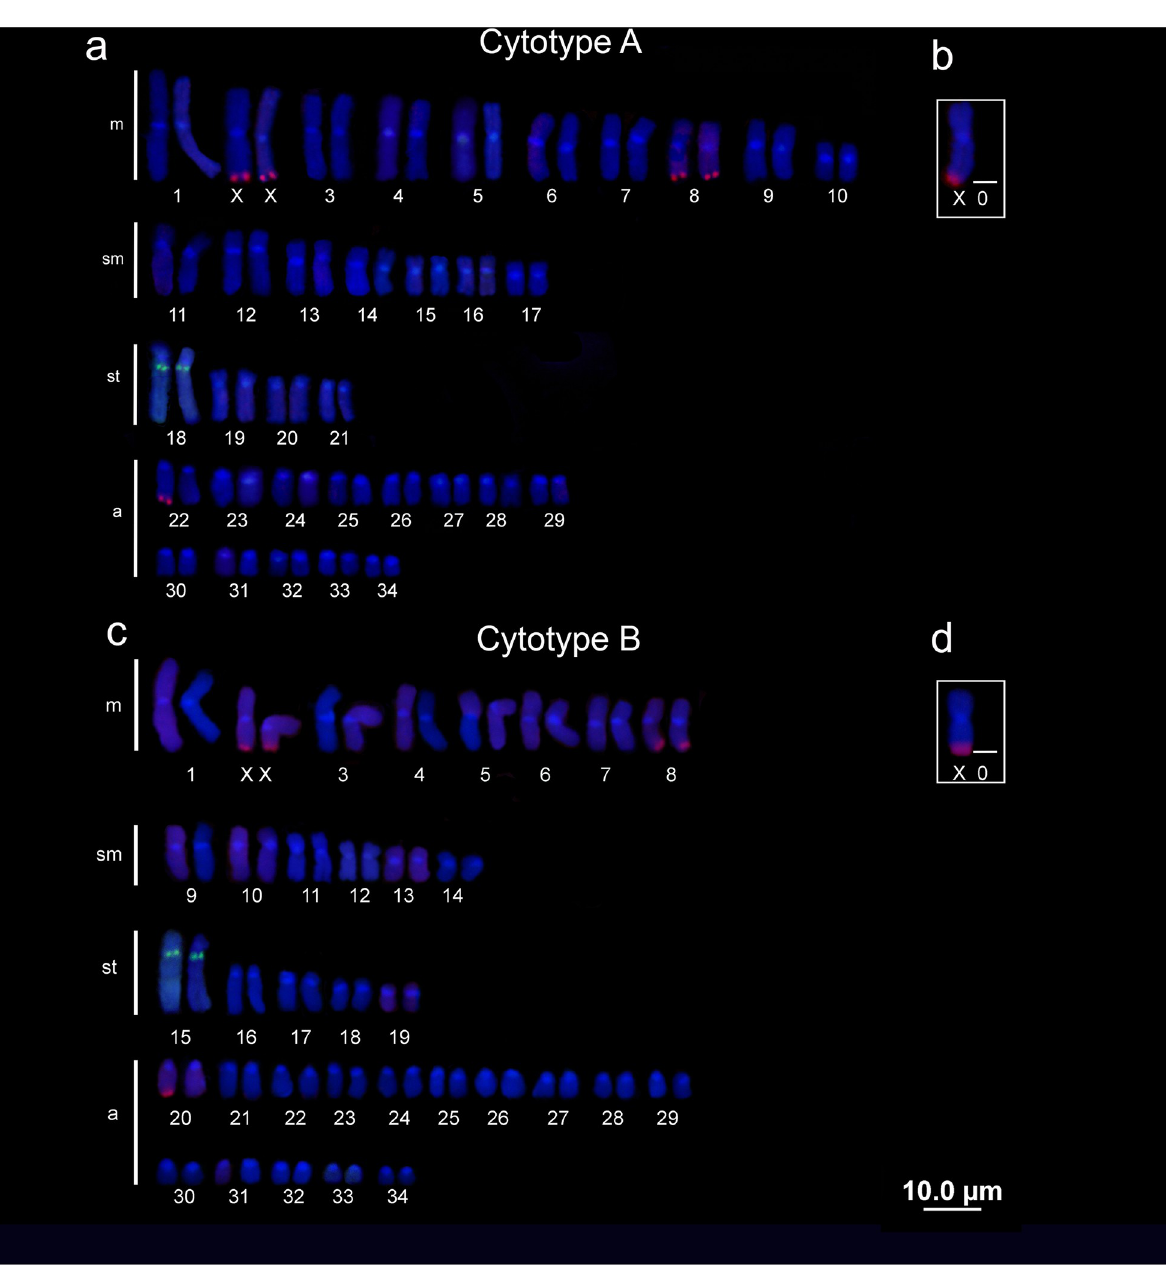
Fig 2. Chromosome mapping of 18S and 5S rDNAs. Chromosome mapping of 18S (red) and 5S (green) rDNAs in cytotype A (a-b) and cytotype B (c-d).